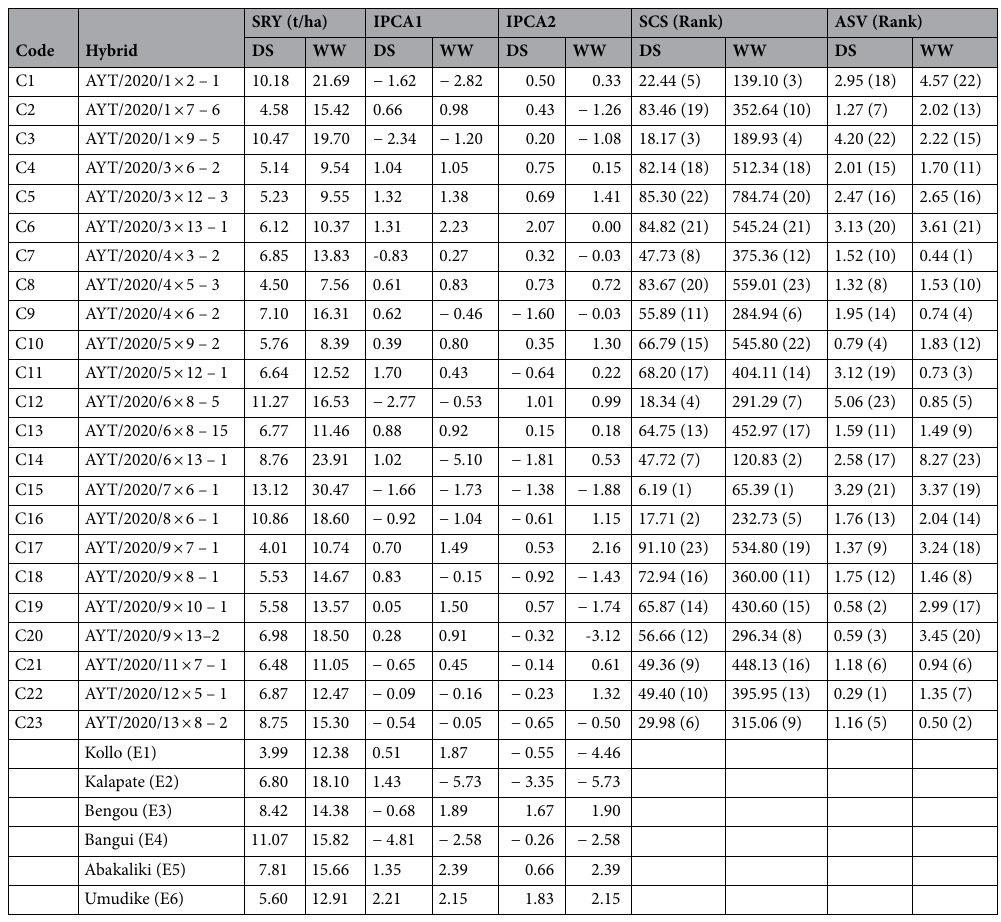
Table 5. Storage root yield, stability cultivar superiority and stability parameters of sweetpotato hybrids under drought and well-watered conditions. C clone, AYT advanced yield trial, SRY storage root yield, IPCA1 interaction principal component analysis 1, IPCA2 interaction principal component analysis 2, SCS stability cultivar superiority, ASV AMMI stability value, DS drought stress, WW